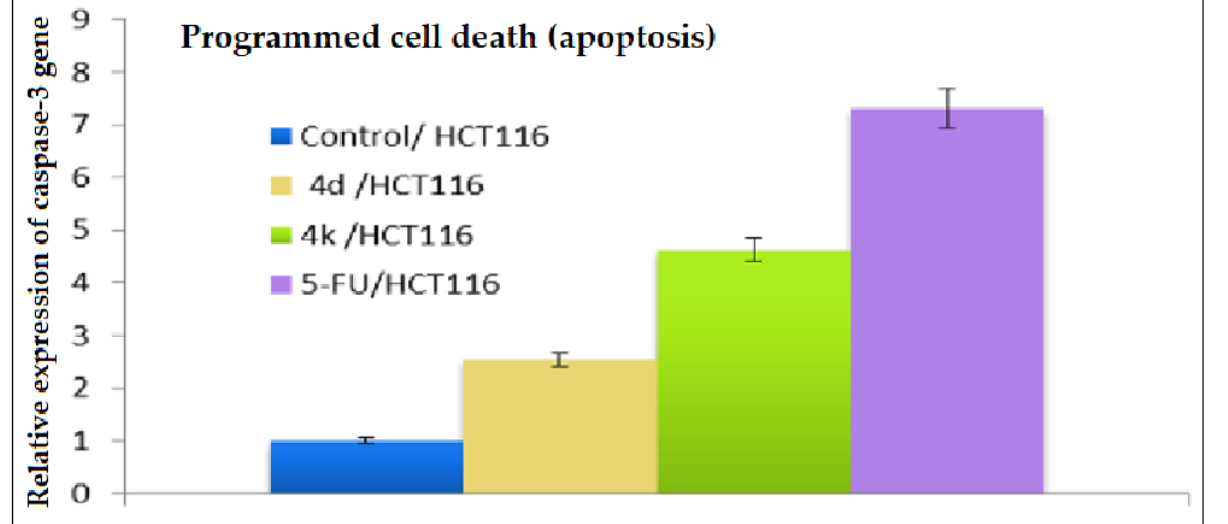
Figure 19. The expression profiles of caspase-3 genes in lysates of HCT-116 cells treated with 5-FU and pyrans 4d and 4k as compared to the untreated HCT-116 cells (negative control).